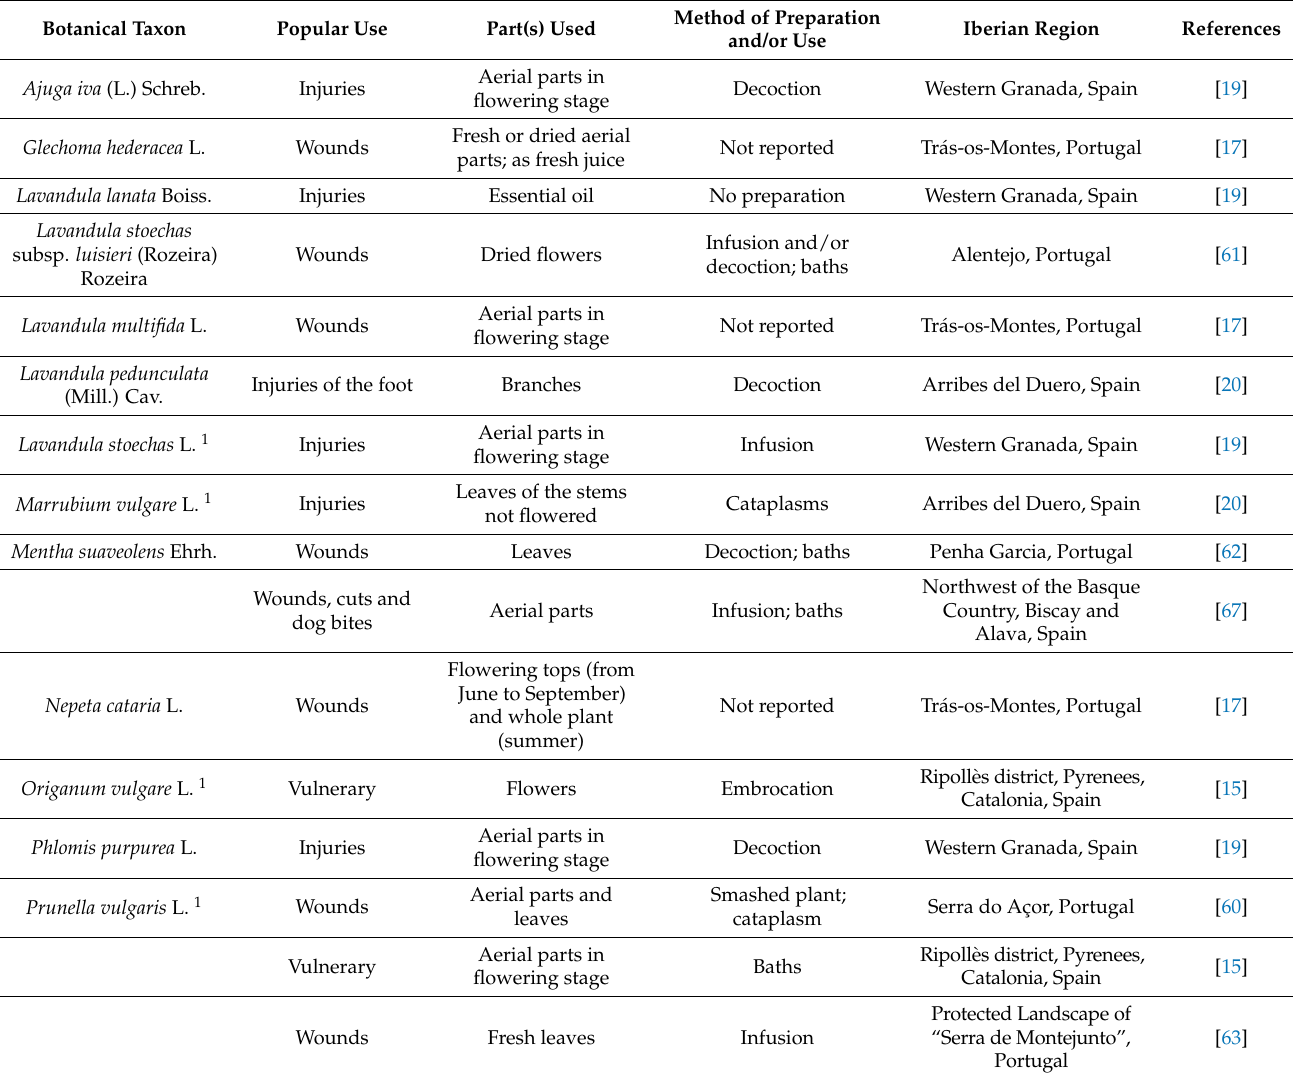
Table 1. Lamiaceae species used in wound healing in the Iberian